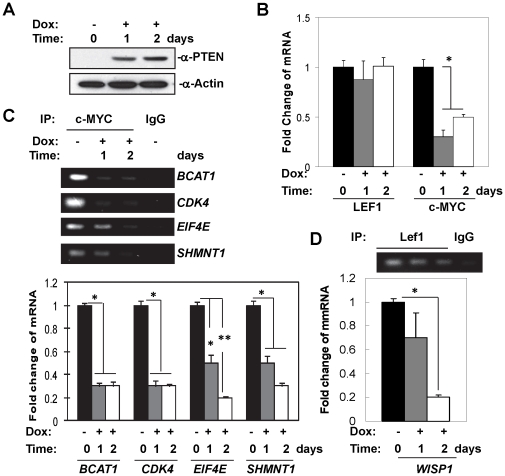
PTEN re-expression downregulates activities of c-MYC and LEF1 in PTEN-inducible PC3 cells.(A) Immunoblot showing PTEN expression levels under Doxycycline induction. (B) Bar graphs showing fold changes of c-MYC and LEF1 mRNA expression by qPCR analysis. (C and D) Bar graphs showing the target gene expression of c-MYC and LEF1 by qPCR analysis, respectively. *p<0.05 and **p<0.01.